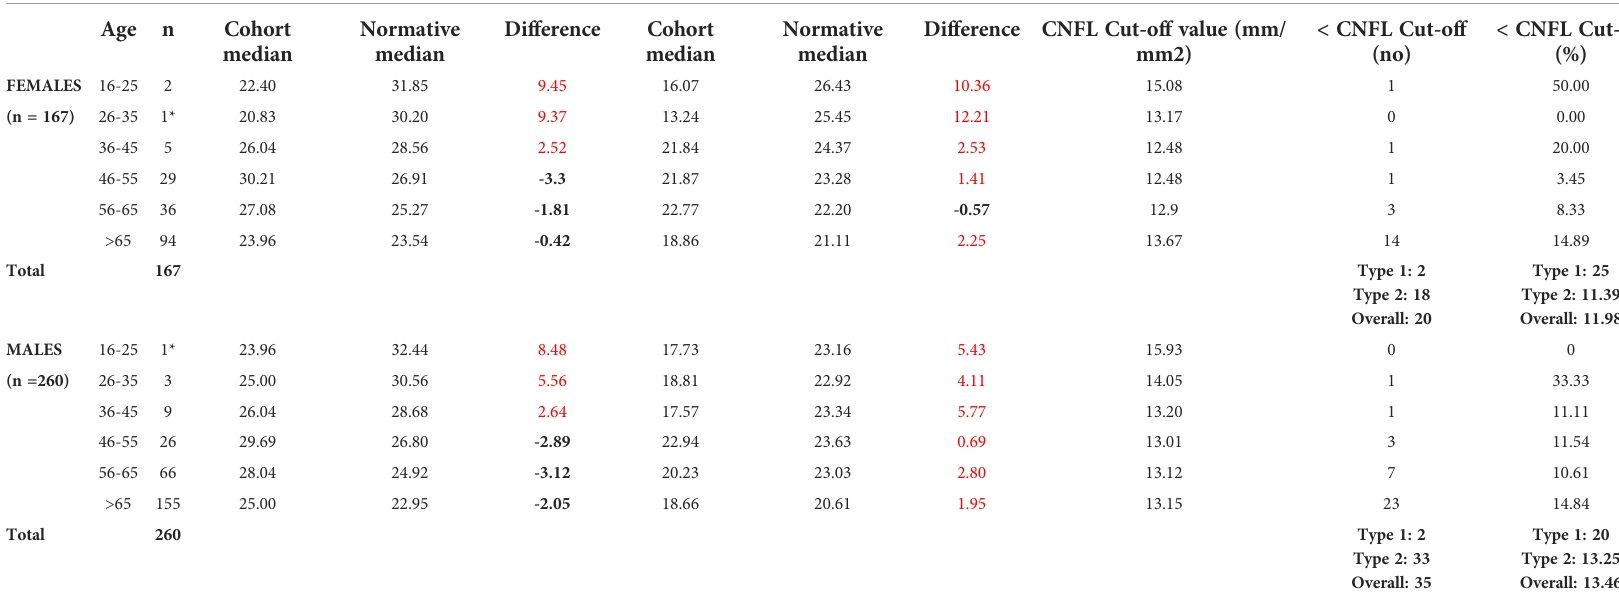
TABLE 4 Comparison to normative age-related median and cut-off values. CNFD